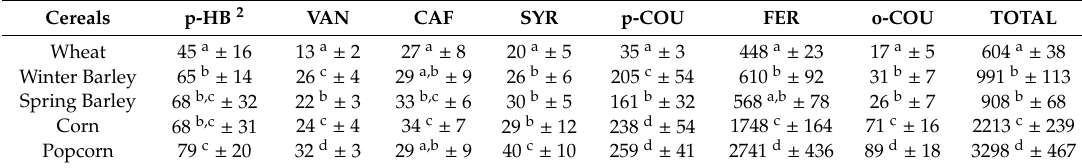
Table 2. Content 1 ( µ g / g dm ) of bound phenolic acids in cereal